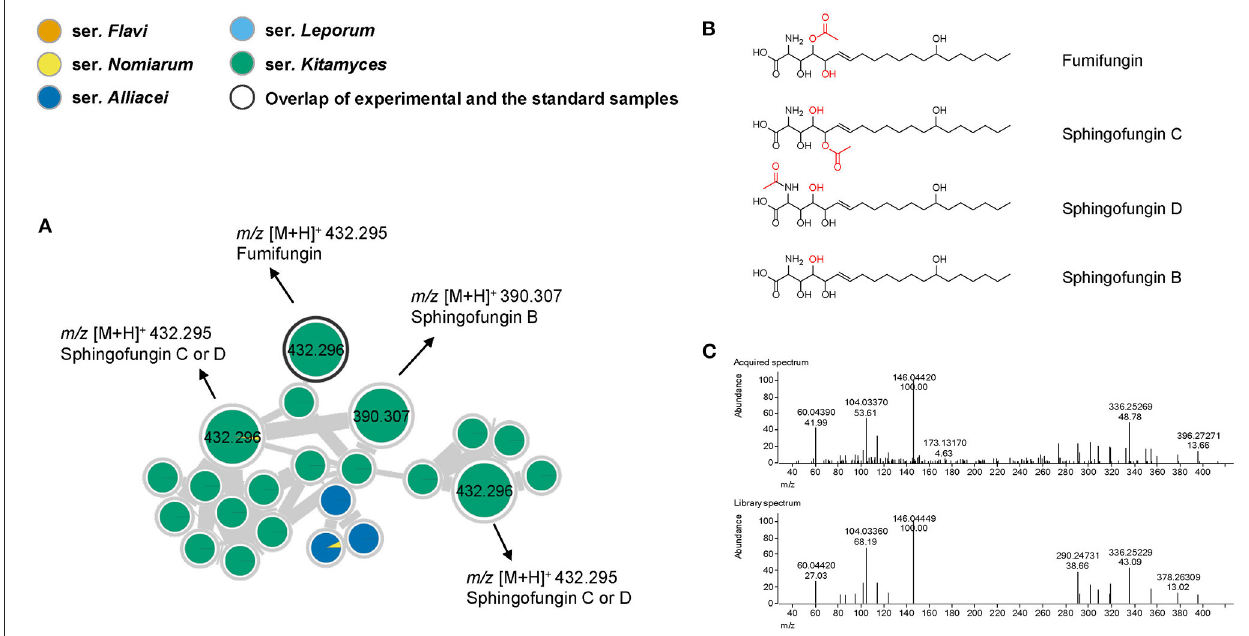
FIGURE 6 | (A) Nodes of compounds related to the fumifungin and sphingofungins. (B) Structures of identified compounds in this cluster. (C) Comparison of MS/MS spectra of fumifungin in acquired spectrum (upper) and library spectrum (lower). Nodes with bold outlined black circles are the overlap of molecules and the standard compounds, the nodes marked with asterisk are the molecules found from the structural relationship shown in molecular